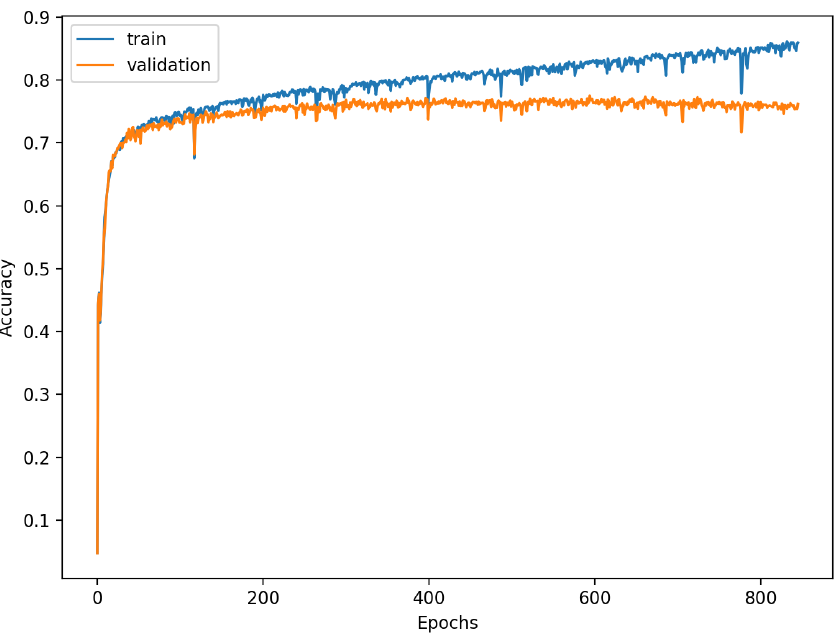
Figure 19. Learning process of the Neural Network for softmax-based classification (5 classes).